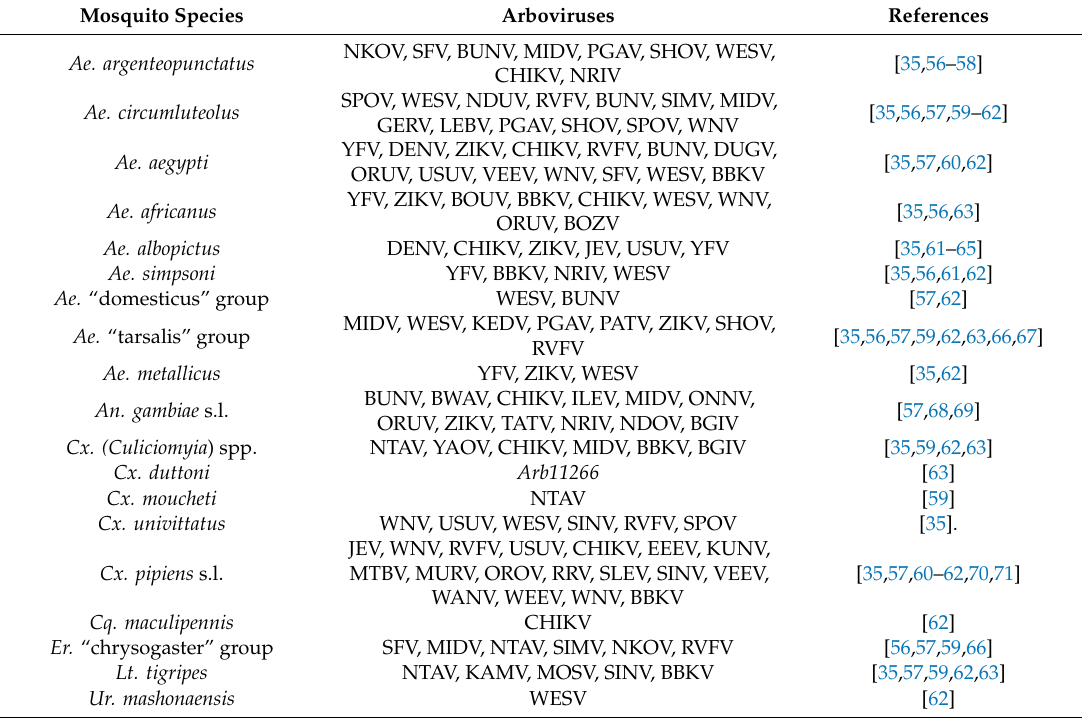
Table 4. Relationship between mosquito species identified in Dschang, West-Cameroon, and some